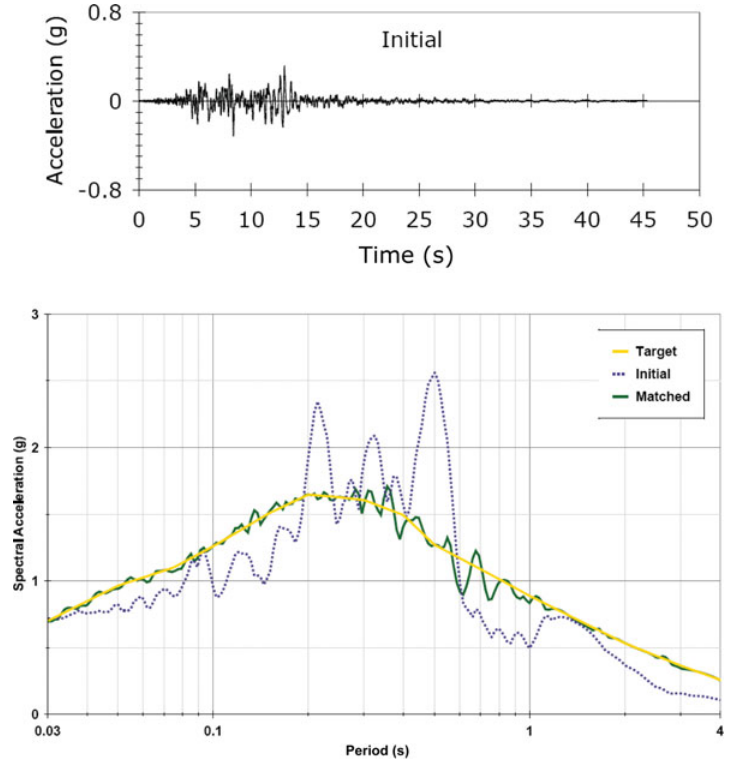
Fig. 3. Sample of a response spectrum-matched time history record (AlHamaydeh, Hussain 2010)